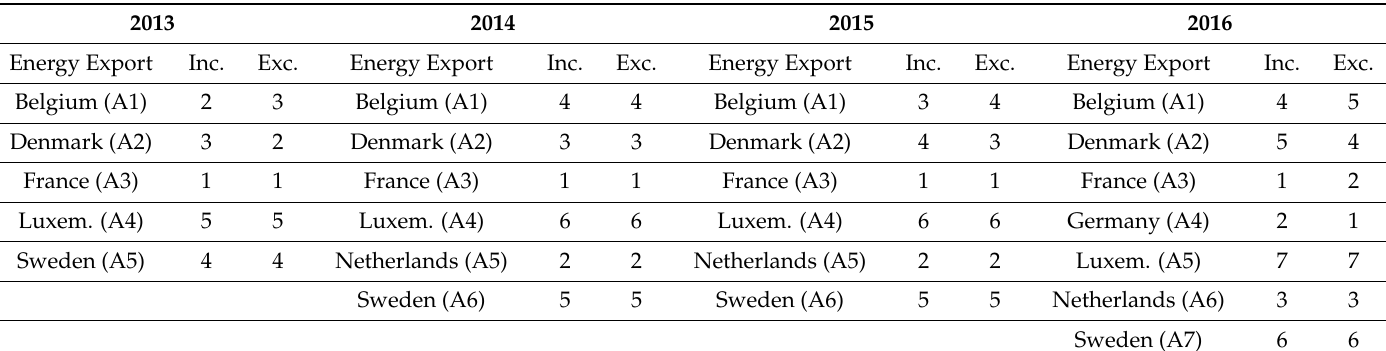
Table 16. Ranking transport export performance of the EU countries in case of including and excluding the energy trade. 2013 Energy Export Inc.